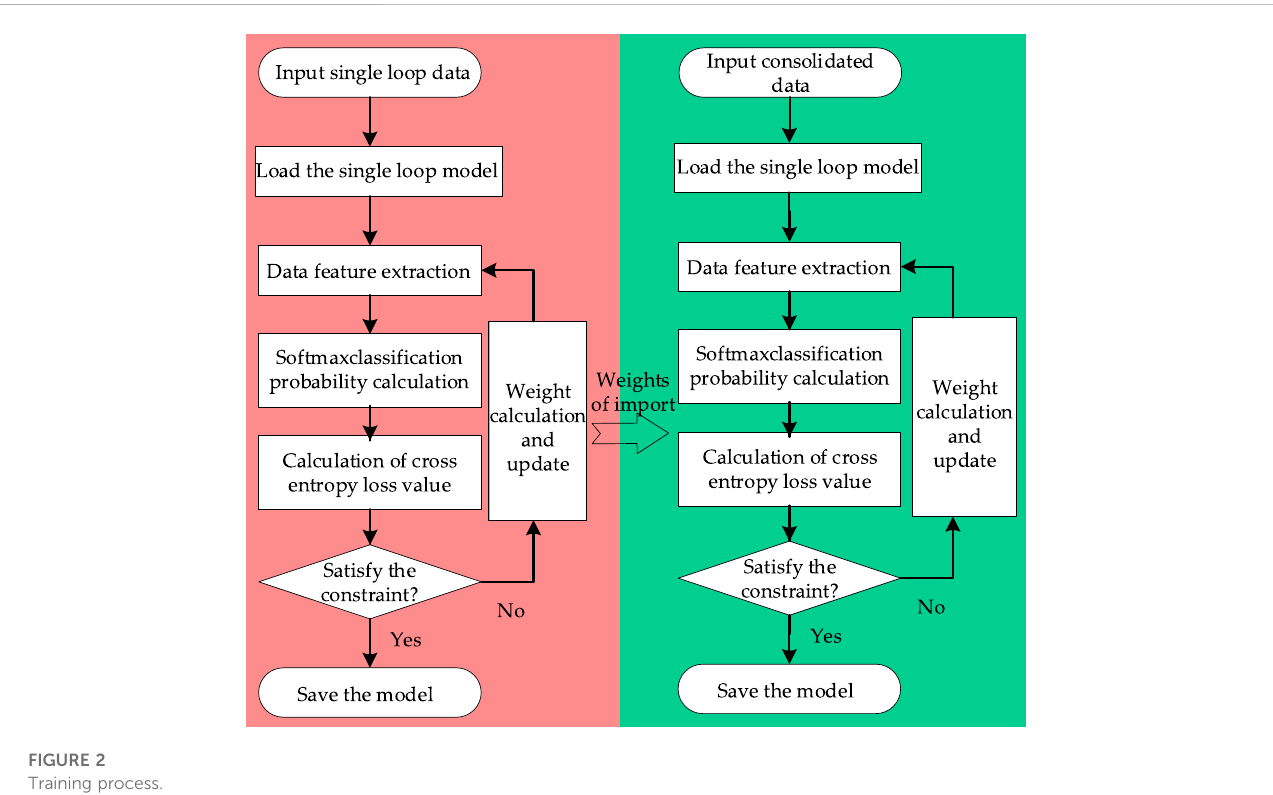
FIGURE 2 Training